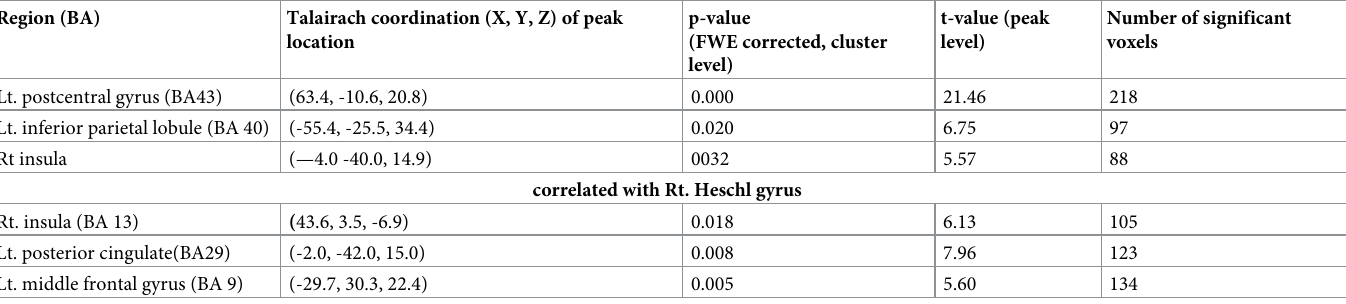
Fig 11B), and left middle frontal gyrus (BA 9; Fig 11C) significantly correlated positively with the activity in the right HSC (Table 2). DTI TBSS revealed a cluster of significant FA reductions in patients compared to controls. This cluster included the bilateral anterior cingulate, right posterior cingulate, deep white matter in